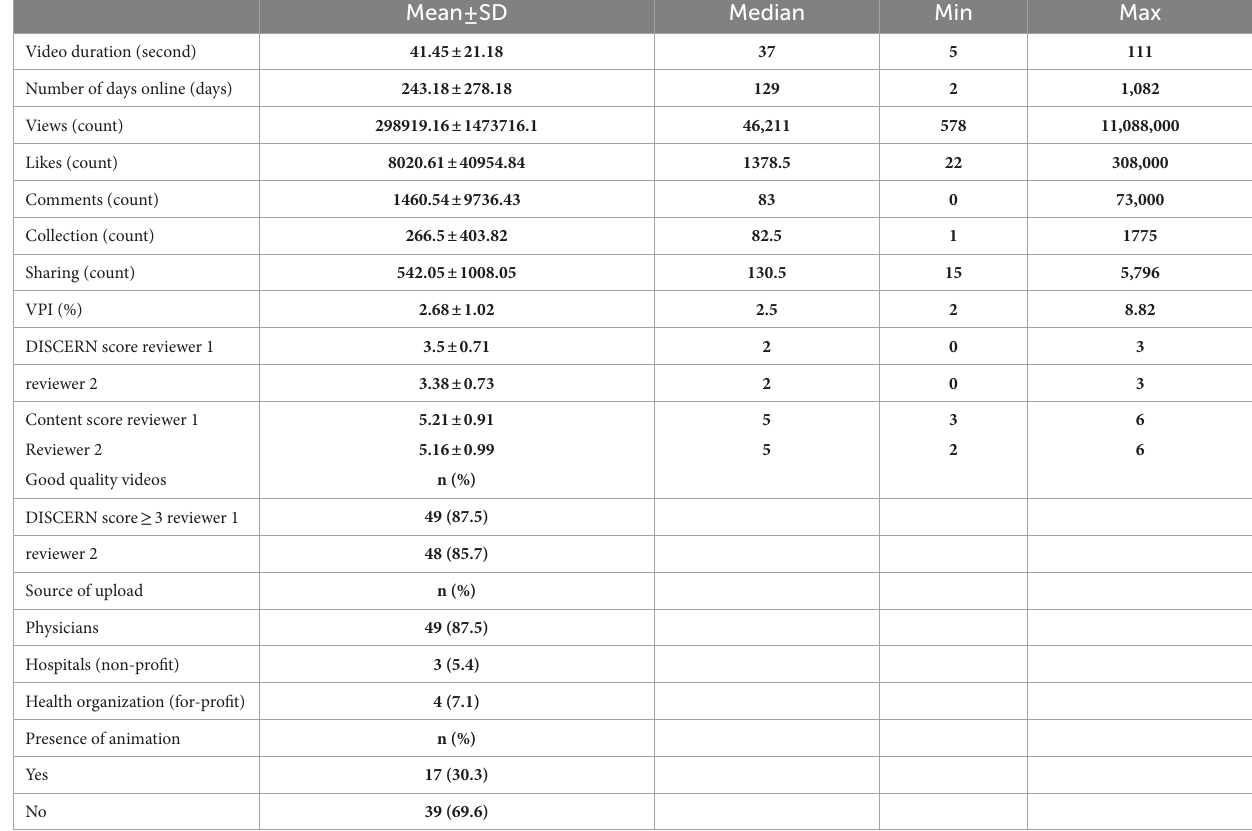
TABLE 2 General characteristics of the videos.